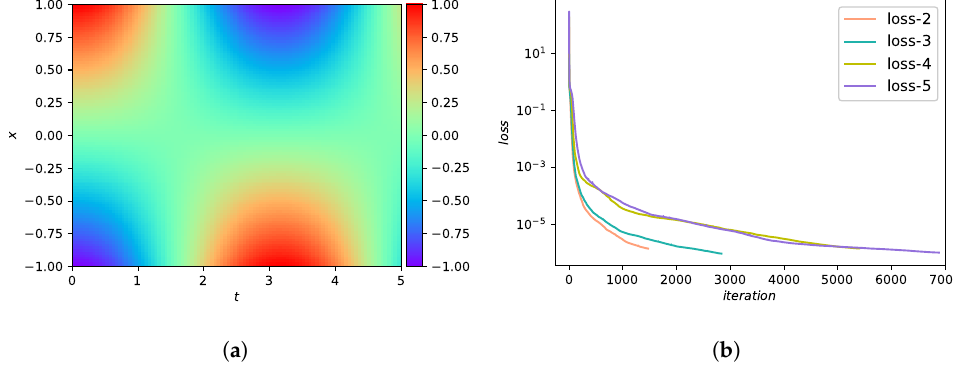
Figure 9. Results of Equation (34). ( a ) The predicted solution u ( t , x ) . ( b ) The change process of the objective function versus iteration number.